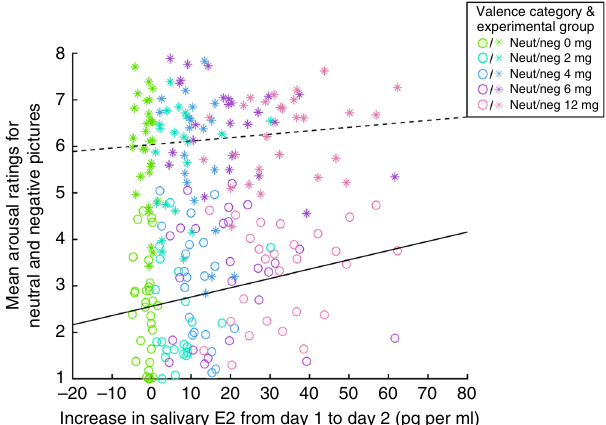
Fig. 4 Linear regression between E2 increases and mean arousal ratings. Negative pictures are represented by asterisks, neutral pictures by circles. Colors represent experimental groups ( N = 123). A signi fi cant positive linear relationship was observed between salivary E2 increase and arousal ratings for neutral pictures (solid line; p corr = .015) but not negative pictures (dashed line; p corr =